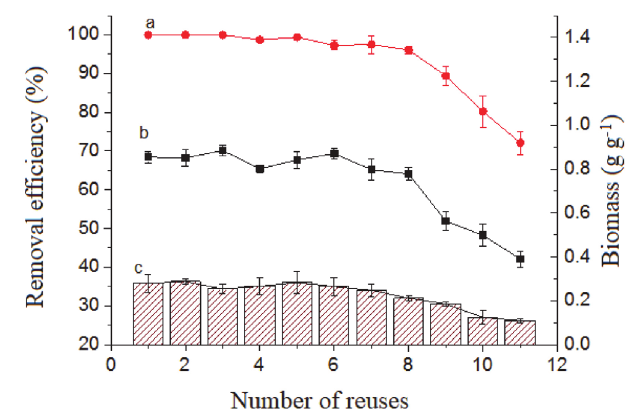
Fig. 9 – Effect of reuse number on AN removal (a), TN re- moval (b) and Biomass